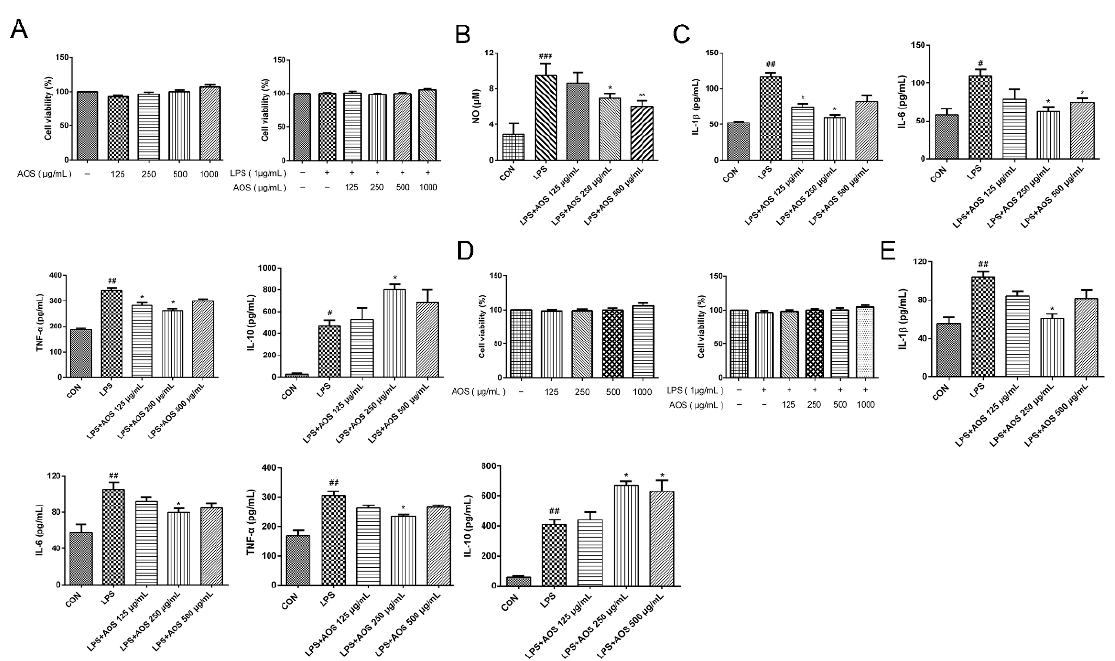
Figure 1. AOS anti-inflammatory activity in LPS-induced RAW 264.7 and BMDM cells. ( A ) MTT assay of viability in RAW 264.7 cells. RAW 264.7 cells were preincubated separately with AOS at 125, 250, and 500 μ g/mL for 24 h, followed by stimulation with or without 1 μ g/mL LPS for another 24 h. ( B ) NO production in RAW 264.7 cells as tested by NO assay kit. ( C ) ELISA analysis of IL-1 β , IL-6, TNF- α , and IL-10 levels in RAW 264.7 cells. ( D ) MTT assay of viability in BMDMs. BMDMs were preincubated separately with AOS at 125, 250, and 500 µ g/mL for 24 h, followed by stimulation with or without 1 µ g/mL LPS for another 24 h. ( E ) ELISA analysis of IL-1 β , IL-6, TNF- α and IL-10 levels in BMDMs. # p < 0.05, ## p < 0.01, ### p < 0.001 vs. Control group, * p < 0.05, ** p < 0.01 vs. LPS group, n =